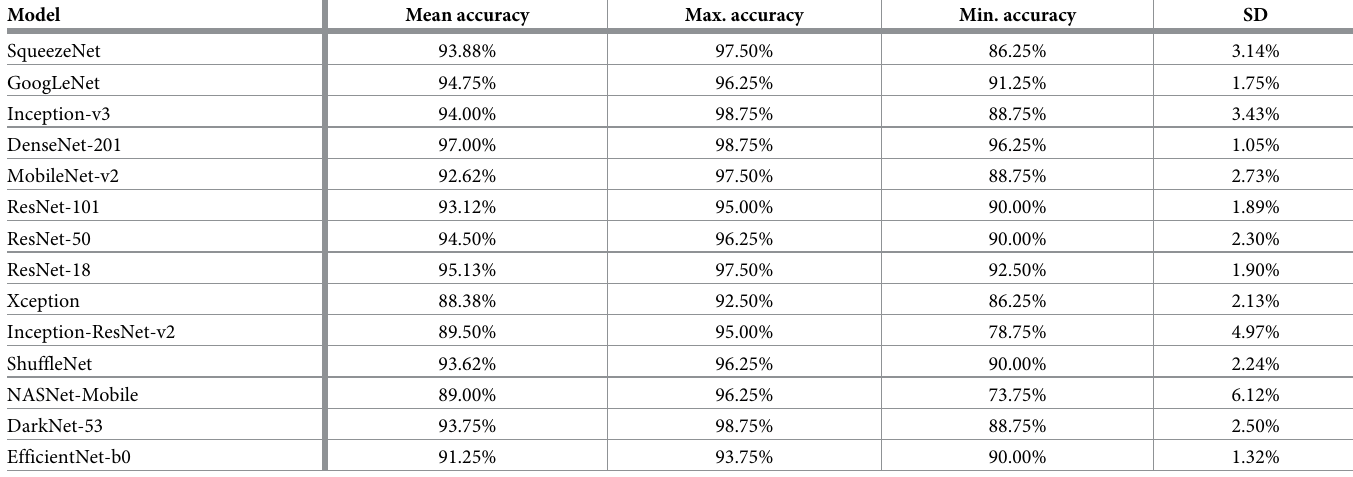
Table 7. The accuracy of classifying X-ray images into two classes; scoliosis, or spondylolisthesis, for each deep learning model. The results are reported for 40 runs of each model. Model Mean accuracy Max.